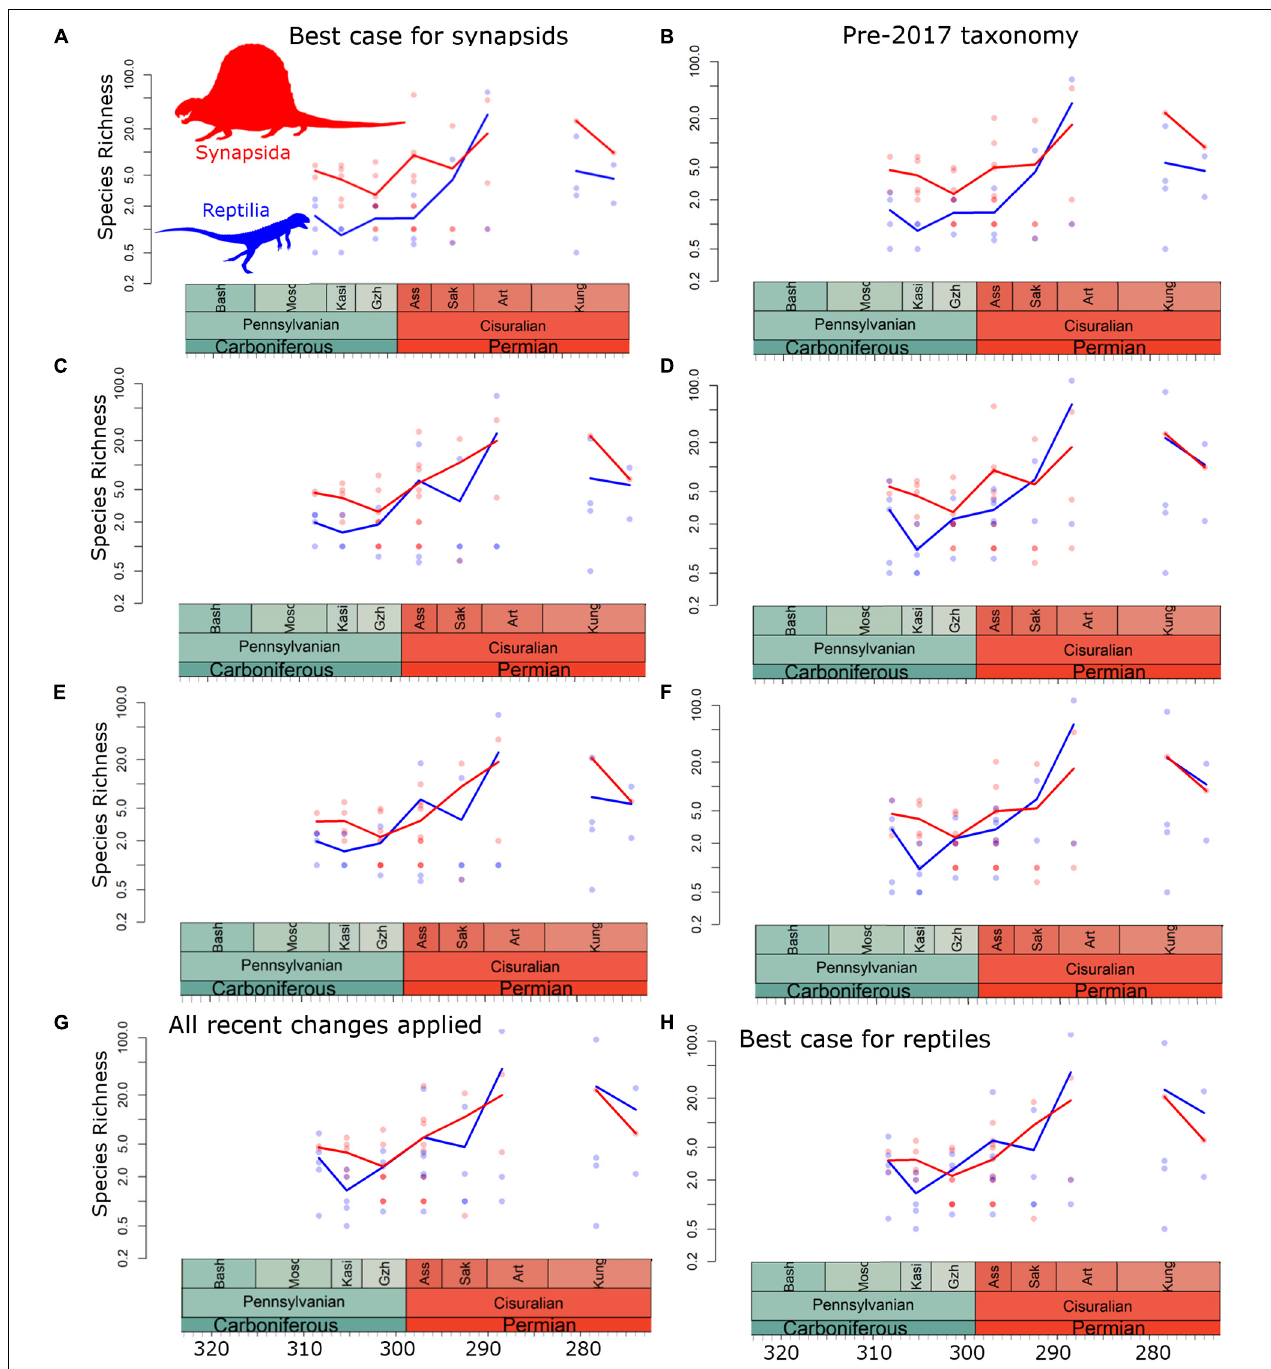
FIGURE 3 | Diversity estimates at the regional scale. Points represent diversity within each bioregion (Blue = reptiles; Red = synapsids). Curve is median diversity within each time bin. (A) Taxonomic scheme 1; (B) Taxonomic scheme 2; (C) Taxonomic scheme 3; (D) Taxonomic scheme 4; (E) Taxonomic scheme 5; (F) Taxonomic scheme 6; (G) Taxonomic scheme 7; (H) Taxonomic scheme